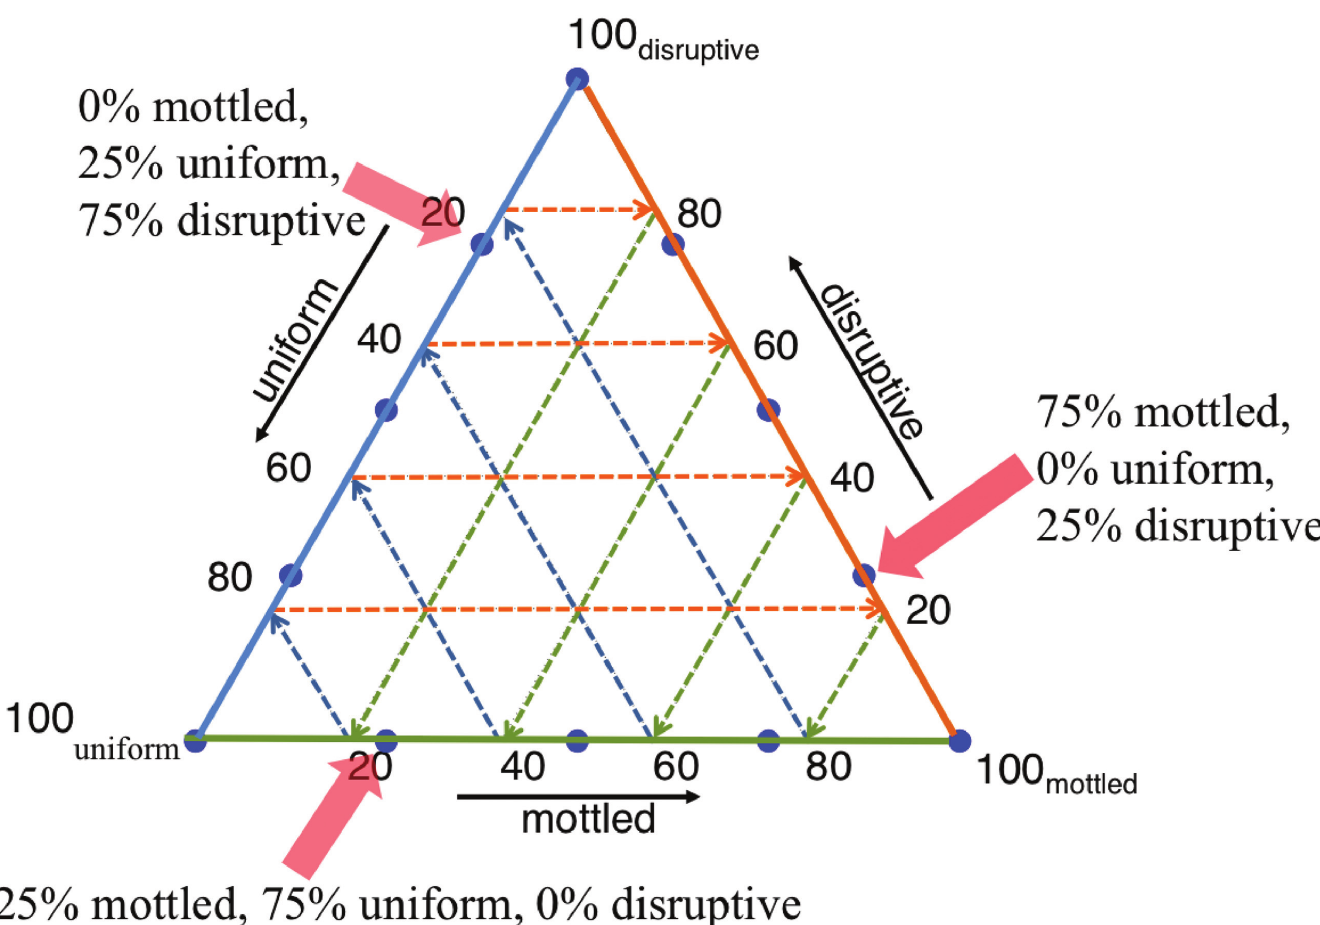
Fig 4. Example ternary plot showing the locations of camouflage categories (blue dots along the perimeter). The triangle vertices indicate categories that include only one camouflage pattern. Examples of mixed categories are indicated with the translucent red arrows. Categorizations that are mixtures of mottled and disruptive are along the right triangle perimeter. Classifications that are mixtures of uniform and disruptive coloration are along the left perimeter. Categorizations that are mottled and uniform are long the bottom perimeter. See the text for further information on interpreting ternary